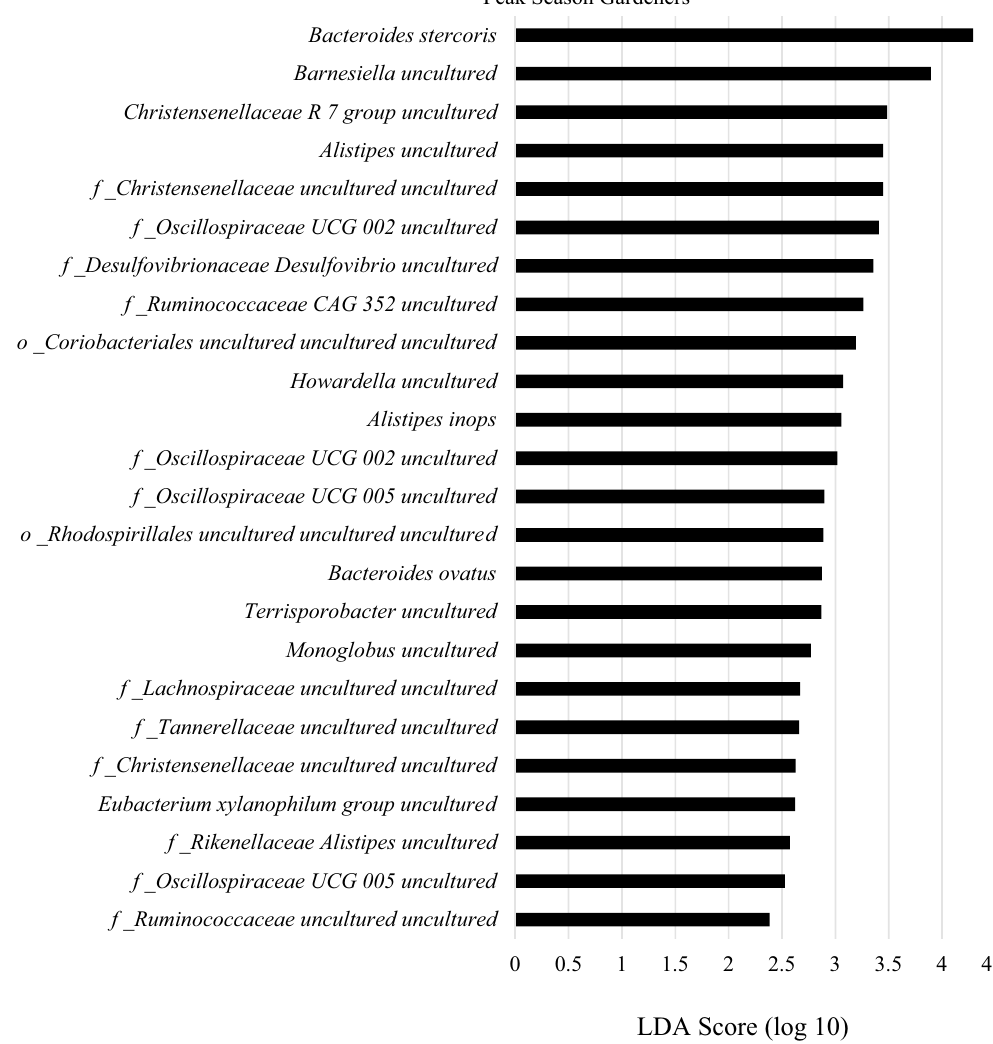
Figure S1). Linear discriminate analysis effect size (LEfSe) of gardening families and control families at peak season revealed that gardening families had higher abundances of several gut microbial species (Fig. 3). Relative abun- dances of these taxa are reported in Table 2. Genus LEfSe scores of gardening families are shown in Supple- mentary Figure S2 with relative abundances in Supplementary Table S1. LEfSe species and genus abundances in control families are in Supplementary Figure S3 and Supplementary Figure S4 with abundances in Supplementary Table S2 and Supplementary Table S3. After p-value adjustment for multiple comparisons, Bacteroides ovatus (p = 0.02) and Eubacterium xylanophi- lum group spp. (p = 0.02) abundances were greater in gardening families than in control families at peak season, although at low abundances (Table 2). The abundance of class level Alphaproteobacteria tended to be 64% higher in gardening families than control families at peak season (p = 0.06). Gardening families also had higher abundances of unassigned taxa. Specifically, gardening families had more unassigned taxonomic genera before the gardening season (2.8%) and at peak season (3.9%) than control families (baseline: 2.0%, peak: 2.7%). Fecal microbiota differences within gardening families across the gardening season. Within gardening family fecal samples, alpha diversity metrics numerically increased from before the gardening season to peak season but were not statistically significant. These metrics included observational features (baseline: 157